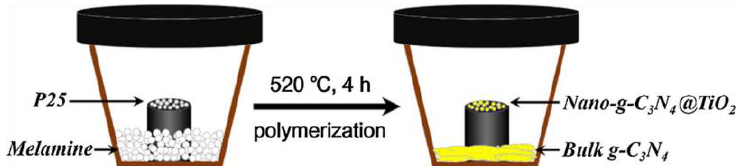
Figure 11. Vapor deposition process in the preparation of g-C3N4/TiO 2 composite. Reprinted with permission from [104]. Copyright 2018, Elsevier.